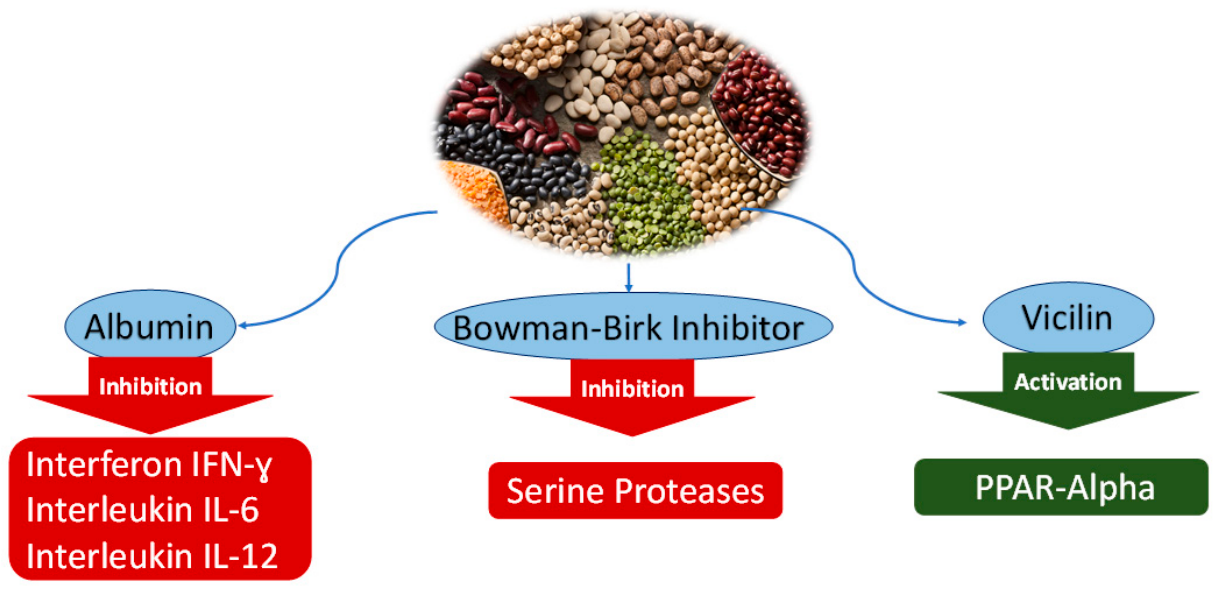
Figure 1. Anticancer mechanisms of soluble protein from water extract of Leguminosae. Inhi- bition of interleukins and serine proteases by albumin and Bowman–Birk Inhibitor, activation of PPAR- α by vicilin.